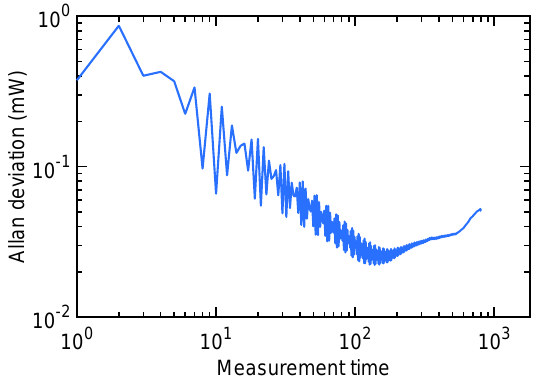
Figure A1. Allan deviation of the laser power as a function of the averaging